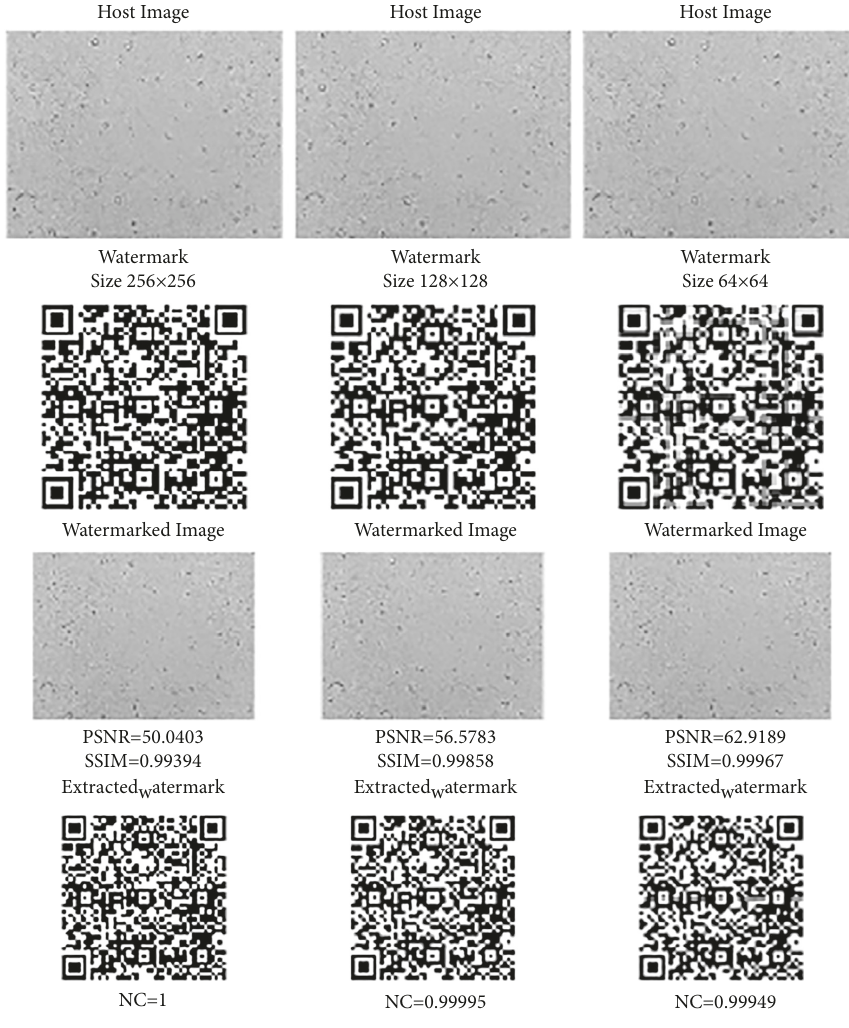
Figure 17: Invisibility performance of blood